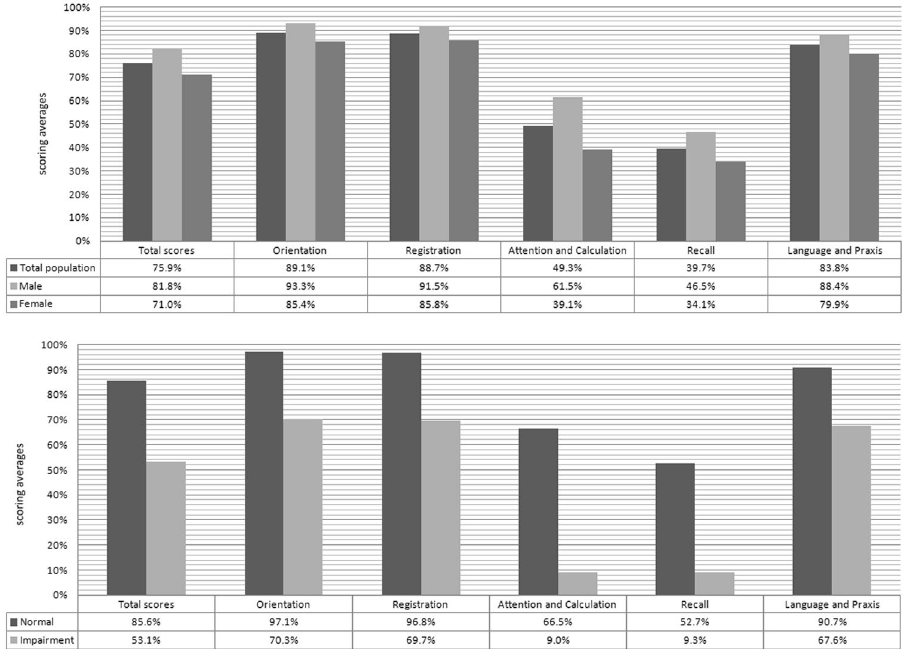
Figure 3. Domain-specific cognitive function by gender and diagnosis of cognitive impairment. Five domain- specific MMSE scores were transformed to a 0–100% scale (sum of the points earned divided by the total points possible). The scoring averages were